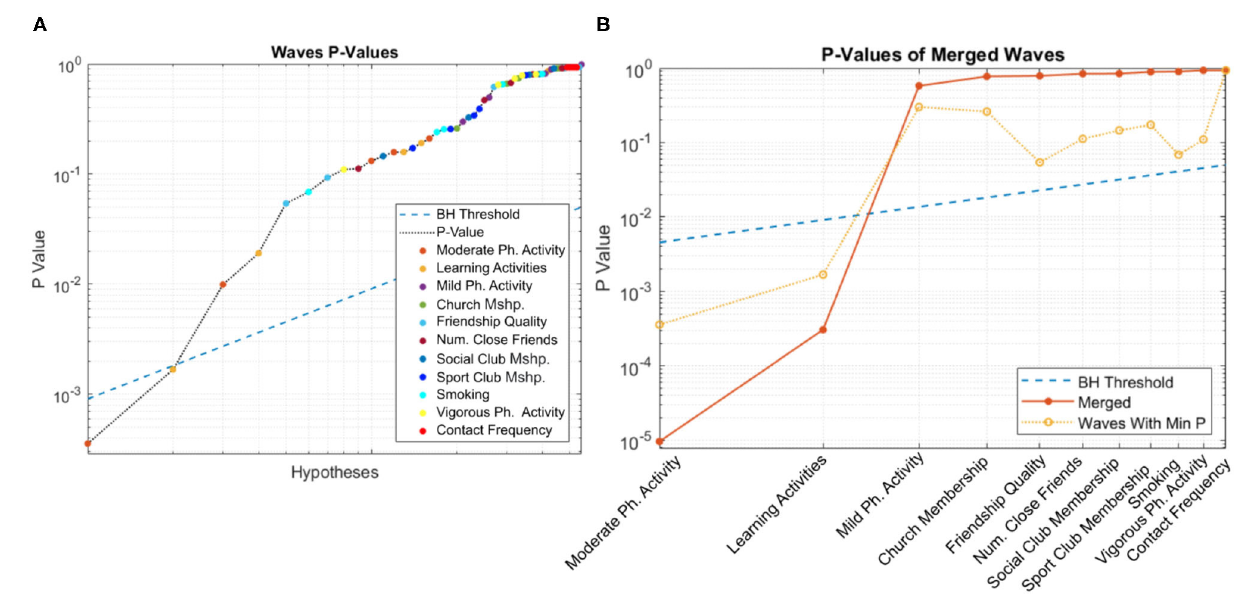
FIGURE 3 | Distribution of p -values for (A) individual and (B) merged populations. In both cases, learning activities and moderate-intensity physical activity pass multiple hypothesis testing.